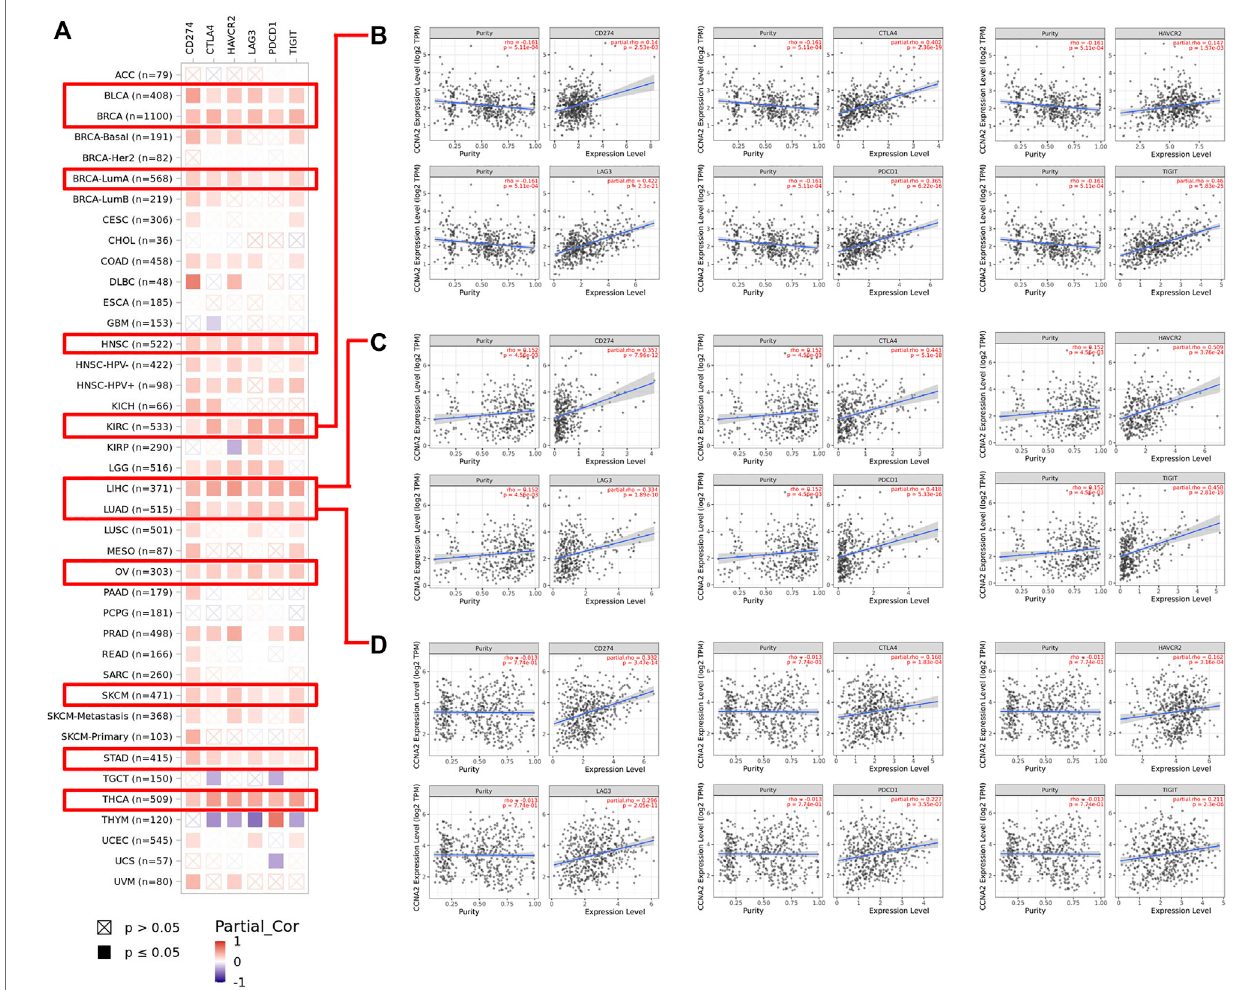
FIGURE 7 | (A) Potential correlation between CCNA2 expression and immune checkpoints (CD274, CTLA4, HAVCR2, LAG3, PDCD1, and TIGIT) in all TCGA cancer types. (B – D) The scatter plots of related cancers generated by the TIMER algorithm, indicating correlation between immune checkpoints (CD274, CTLA4, HAVCR2, LAG3, PDCD1 and TIGIT) and CCNA2 expression in KIRC (B) , LIHC (C) and LUAD (D)